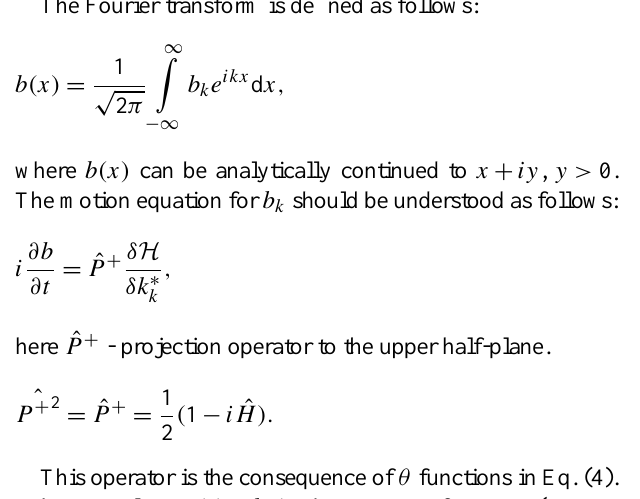
Figure 2. Modulus of b ( x ) with V = 1 / 16 and Ω = 4 . 01.